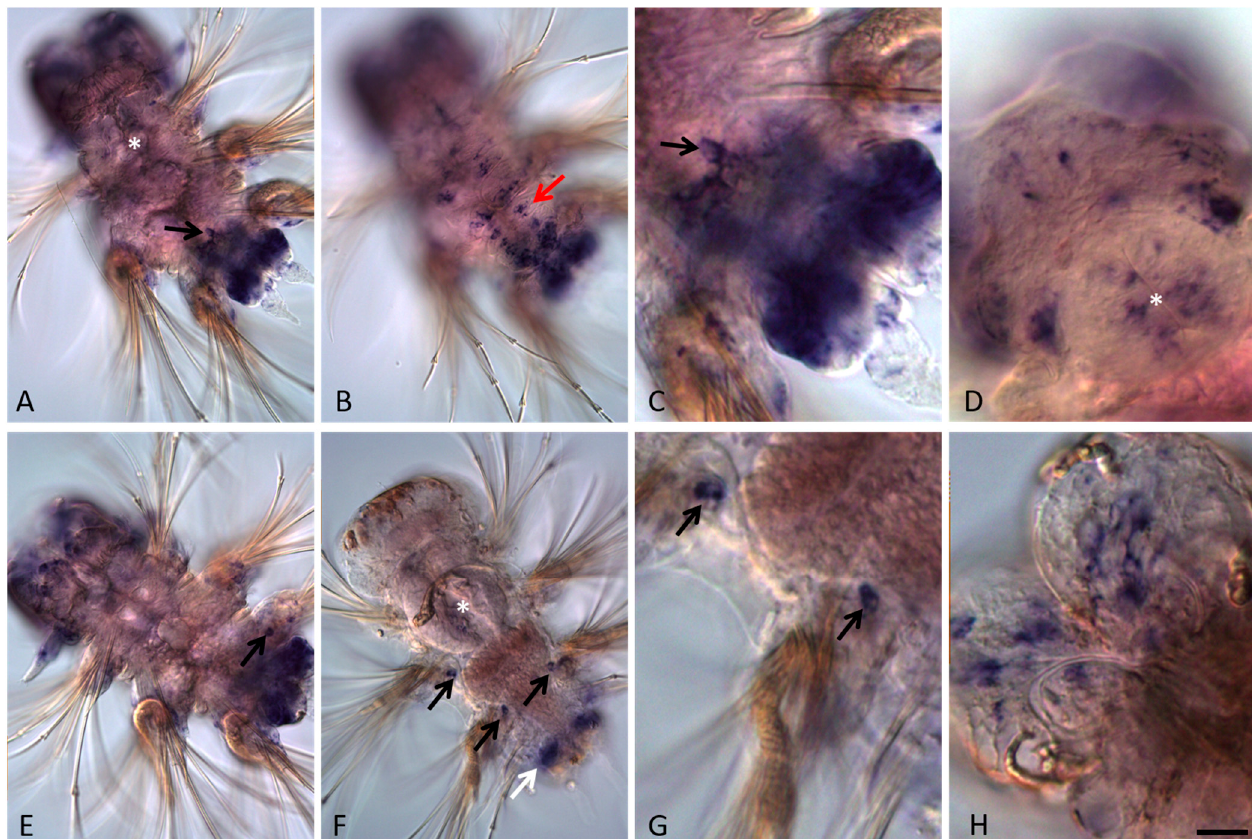
Figure 4. Avi-nanos RNA expression patterns during nectochaete larva development and metamor- phosis into a four-segmented juvenile worm. All animals are oriented anterior to the upper left corner. ( A – D ) Nectochaete at different focal planes; ( E – H ) juvenile animals at different focal planes. ( A ) Avi-nanos is broadly expressed in most caudal area that corresponds with the future posterior growth zone, and in the putative PGCs ( arrow ). ( B ) Expression in the ventral nerve cord ( arrow ); ventral view in a more surface plane. ( C ) Enlarged view of the caudal region of the nectochaete shown in ( A ); dorsal surface view, anterior upward. ( D ) Expression in the pharynx and in the head; view from dorsal side. ( E , F ) Expression in the growth zone and the next-forming segment ( white arrow ). Migrating PGCs ( black arrows ); deep ventral view. ( G ) Enlarged view of the migrating PGCs shown in ( F ). ( H ) Expression in the brain. * marks the pharynx. Scale bar, 40 mkm ( A , B , E , F ); 13 mkm ( C , G , D ); or 16 mkm ( H